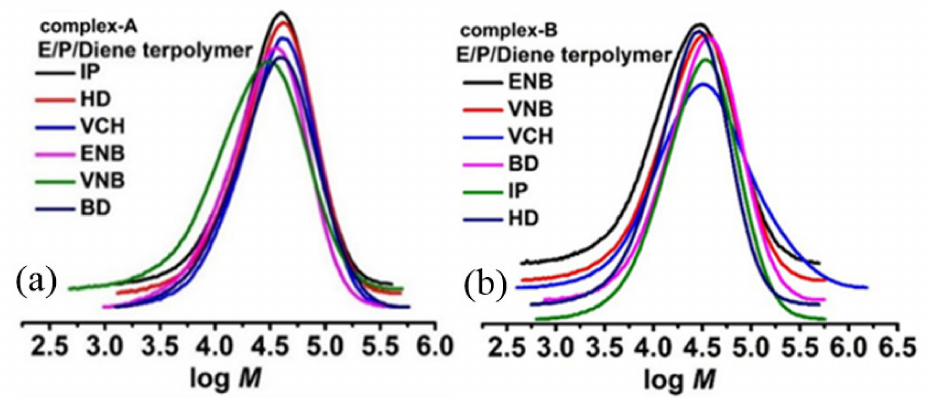
Figure 10. Molecular weight distribution (MWD) for ethylene/propylene/diene (conjugated and nonconjugated) terpolymers produced with ( a ) complex A and ( b ) complex B.